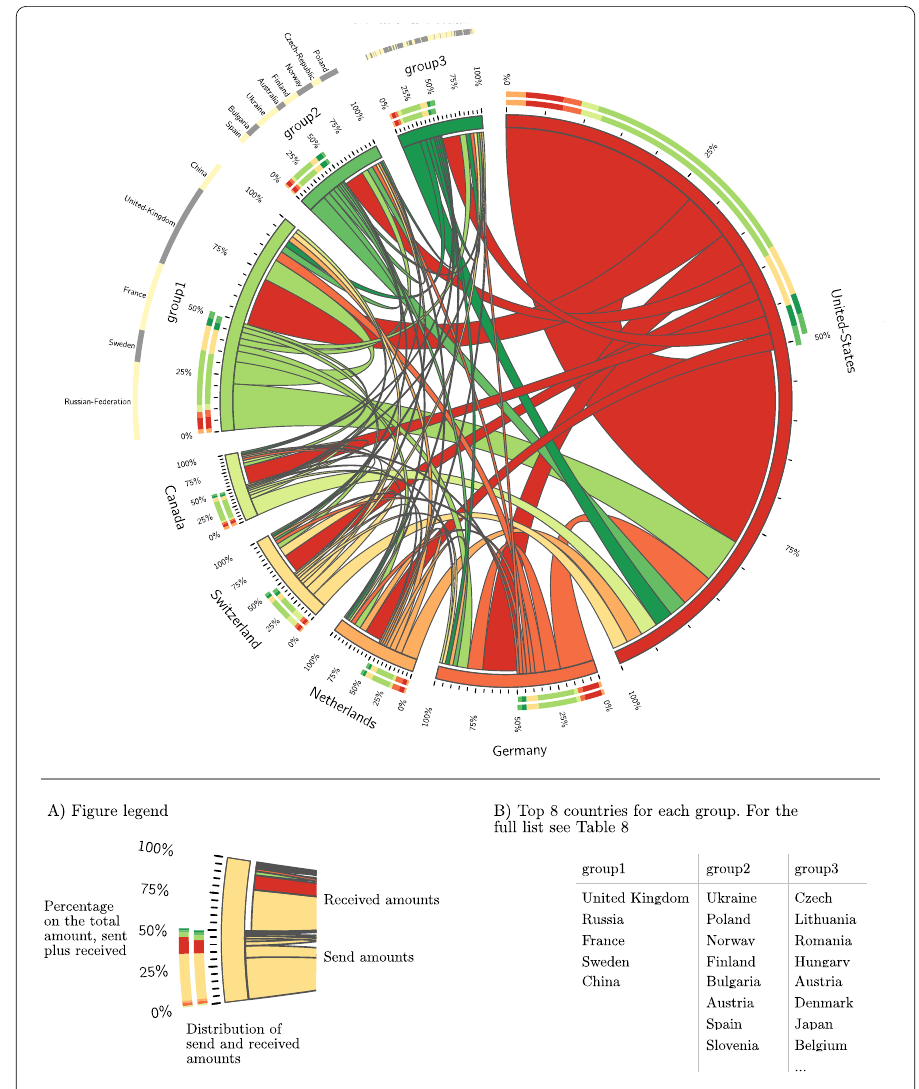
Figure 7 Visualization of the international Bitcoin flow for 2013. The size of each ribbon is proportional to the amount of Bitcoin expressed in dollars exchanged between 2 countries (the colour of a ribbon identifies the sender country). On the external circle we show the repartition of the flow in term of sending (external bar) and receiving (external bar) for each country (or group of countries). The division of countries in groups has been done for visualization’s purpose. The members of the groups are given in Table 9. Countries which were exchanging less than a given amount have been sorted by exchanged amount and separated in 3 groups which gave a total exchanged amount reasonable from the point of view of the visualization. The representation is done using Circos [35]